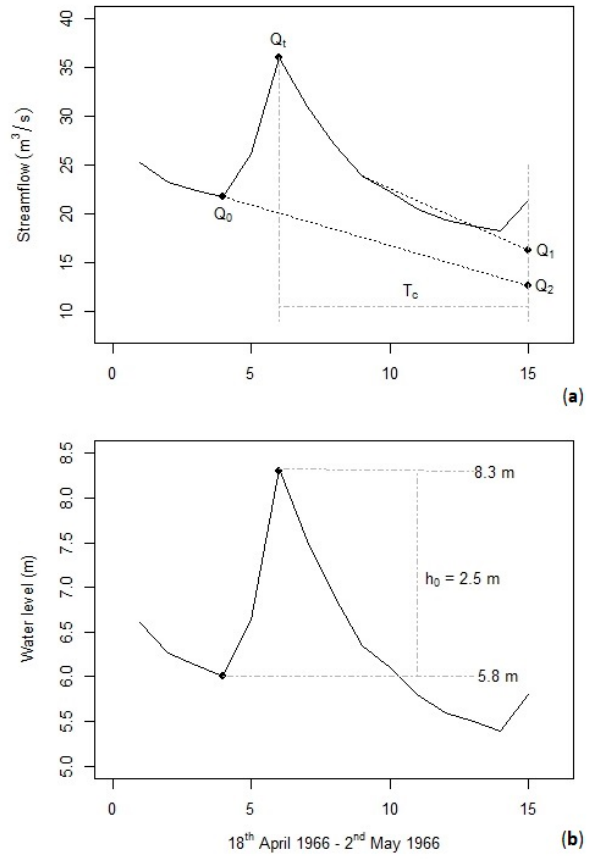
Figure 2. Schematic diagram of the recession-curve-displacement method at 1KB14 gauging station. ( a ) Demonstrates estimation of Q 1 and Q 2 for the wet-season recharge peak occurring on 21 April 1966; ( b ) Demonstrates estimation of h 0 due to recharge event Q t in ( a ).